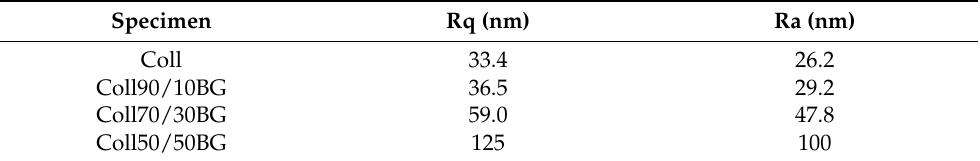
Table 2. Surface roughness parameters for different kinds of films.